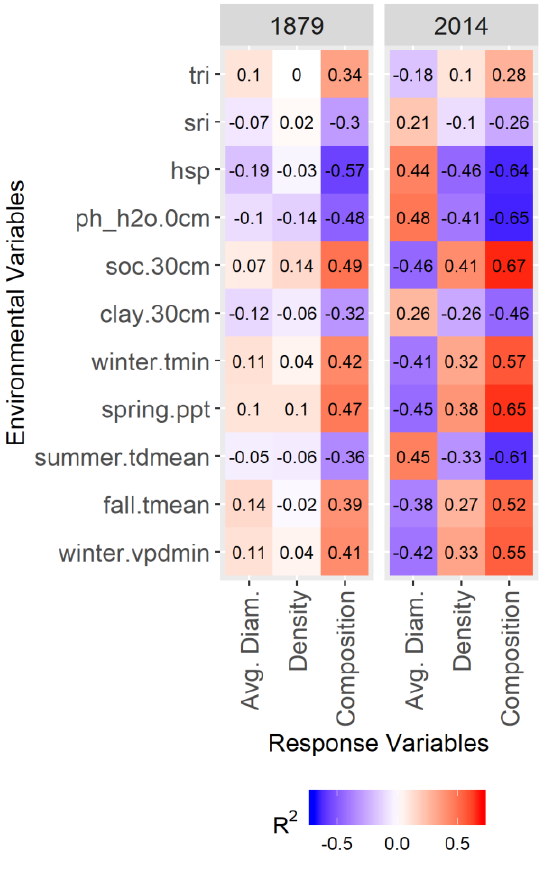
Figure 7. Pearson correlation coefficients between selected predictors and forest structure responses for the subset of environmental variables, and measures of forest structure and composition included in the historical and contemporary models. Strength and direction of the correlation are indicated by color and reported by the correlation coefficient.